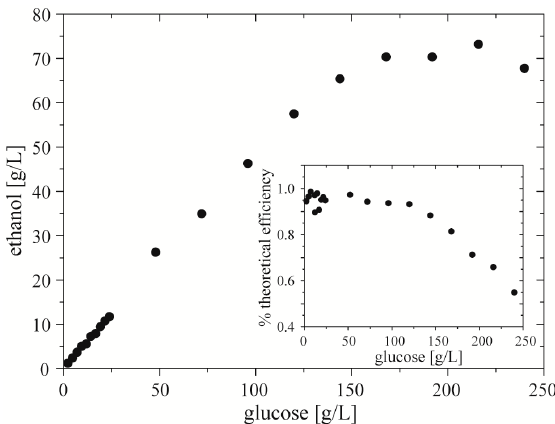
Figure 7. Productivity of ethanol vs. initial concentration of glucose by Z. mobilis . Inset shows percent of theoretical (stoichiometric) efficiency of ethanol production vs. initial concentration of